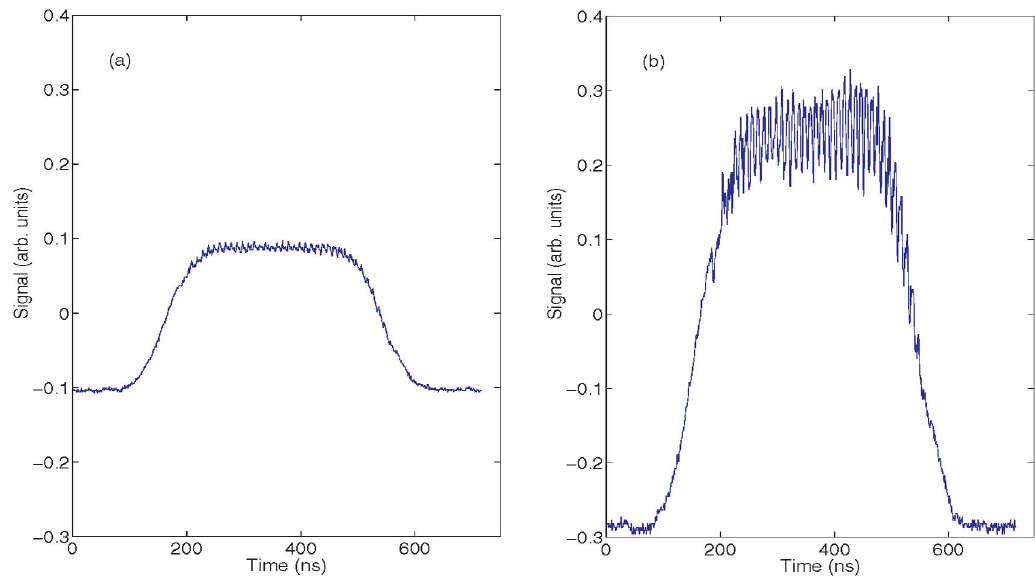
FIG. 4. (Color) (a) Wall current monitor signal for a single turn of a 70 nC chopped beam, 300 turns after the end of injection. The hash at the top is the linac microbunch structure. (b) Wall current monitor signal for a single turn of a 210 nC chopped beam, 300 turns after the end of injection.